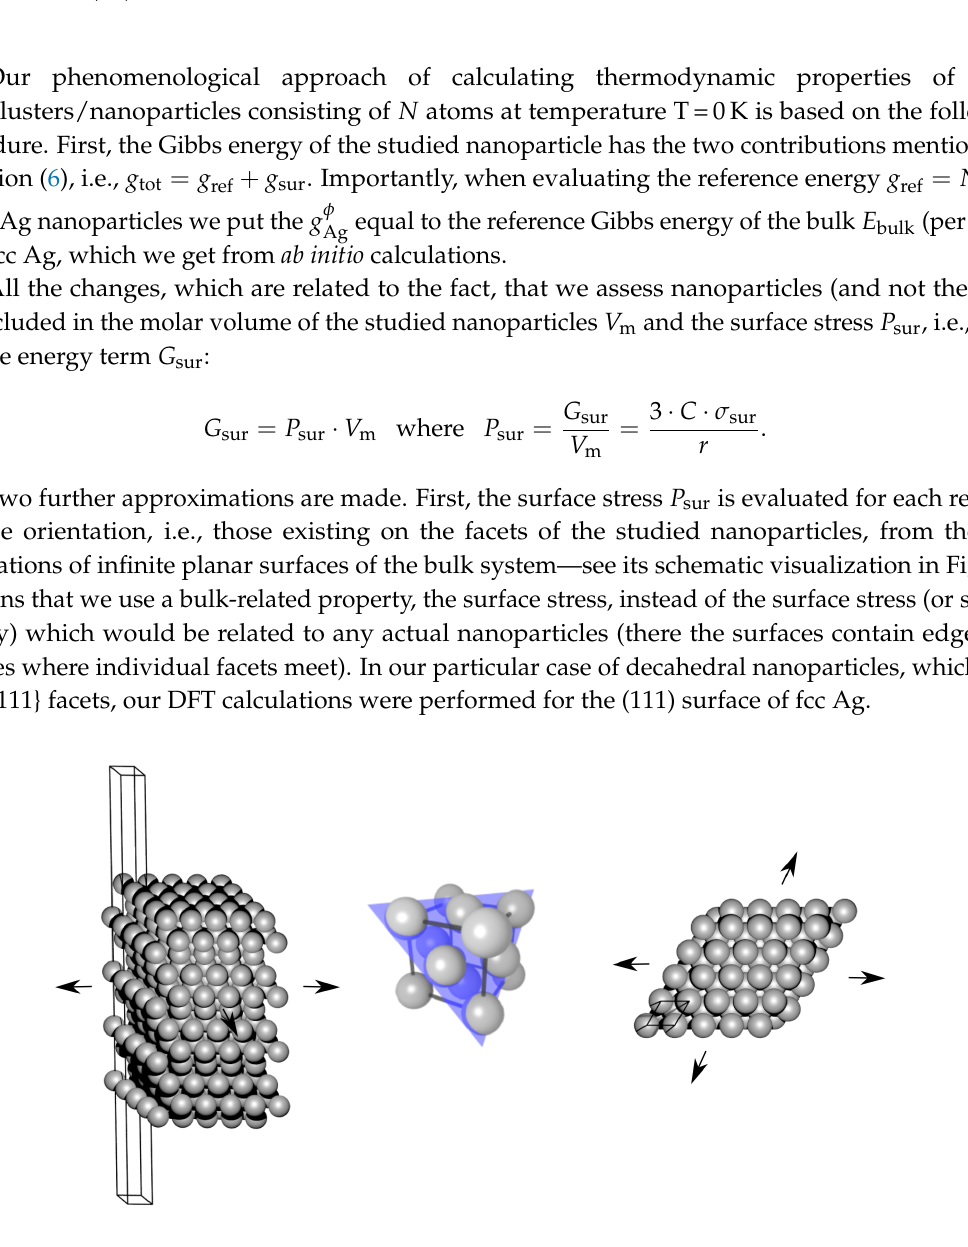
5 multiple of the ×